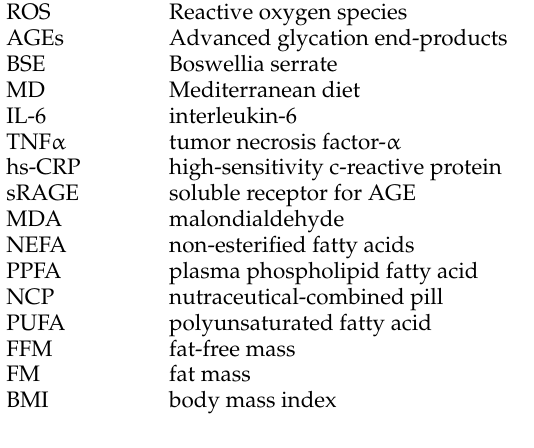
Table S1: Percent differences (after treatment minus before treatment, normalized to before treatment value) in serum fatty acid profile of the two groups of subjects, before and after treatment. Negative values indicate a decrease of the parameter in comparison to before